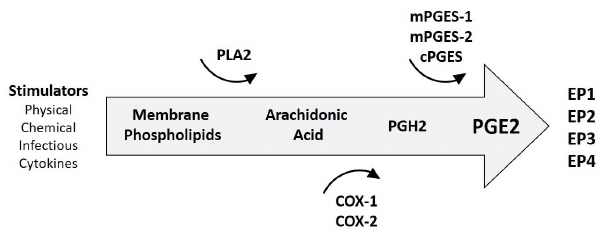
Figure 1. Generation of prostaglandin E2(PGE2). Stimuli, such as chemical damage, physical damage, infections and other inflammatory mediators can trigger synthesis of PGE2. The process starts with the activation of phospholipase A2 (PLA2), an enzyme, which liberates free fatty acids, such as arachidonic acid. Arachidonic acid is converted into prostaglandin H2 (PGH2) by cyclooxygenase 1 and 2 enzymes (COX-1 and COX-2). COX-1 is often referred to as the housekeeping isoform, expressed in many tissues in order to maintain homeostasis, and COX-2 is considered the inducible form, important for augmented prostaglandin synthesis when an inflammatory response is required. PGH2 is